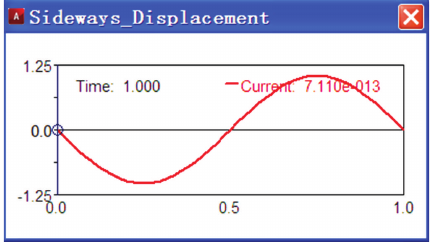
Figure 3: Sideways displacement.